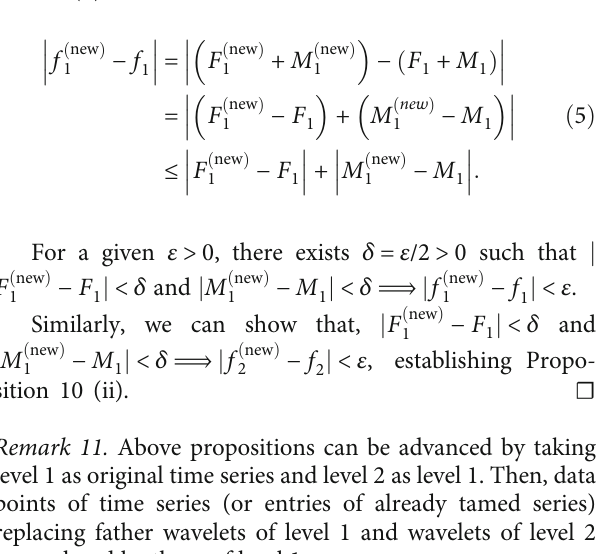
— mother wavelets of series 1 and series 2, and m and m 1 2